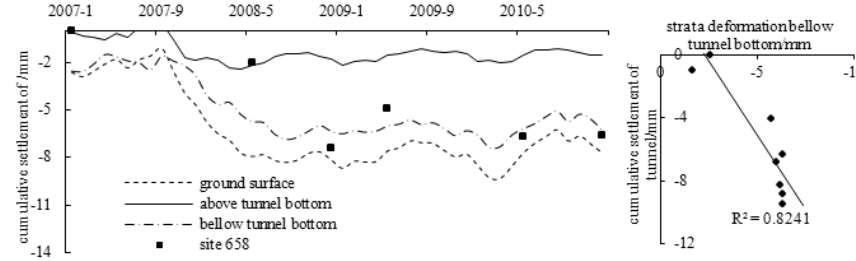
Figure 5. Contrast the monitoring results of point 658 with the ones of